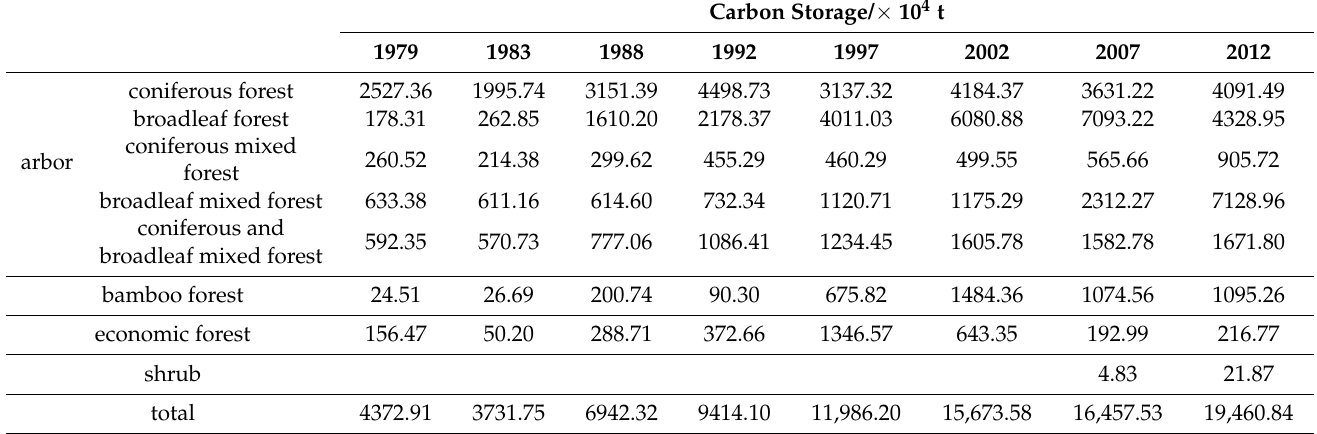
Table 2. Carbon storage in Guangdong Province by forest type.